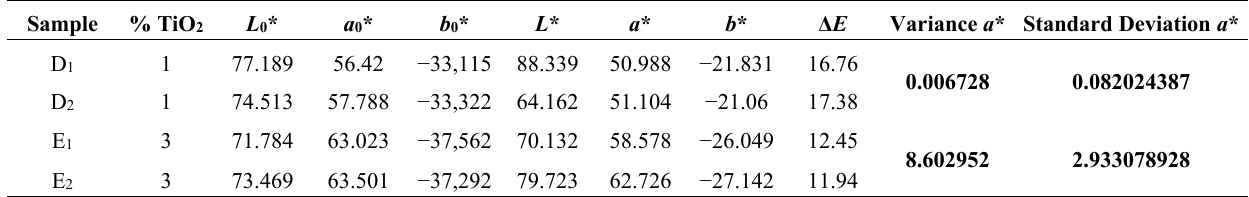
Table 3. Standard deviation of samples with TiO 2 in visible light.